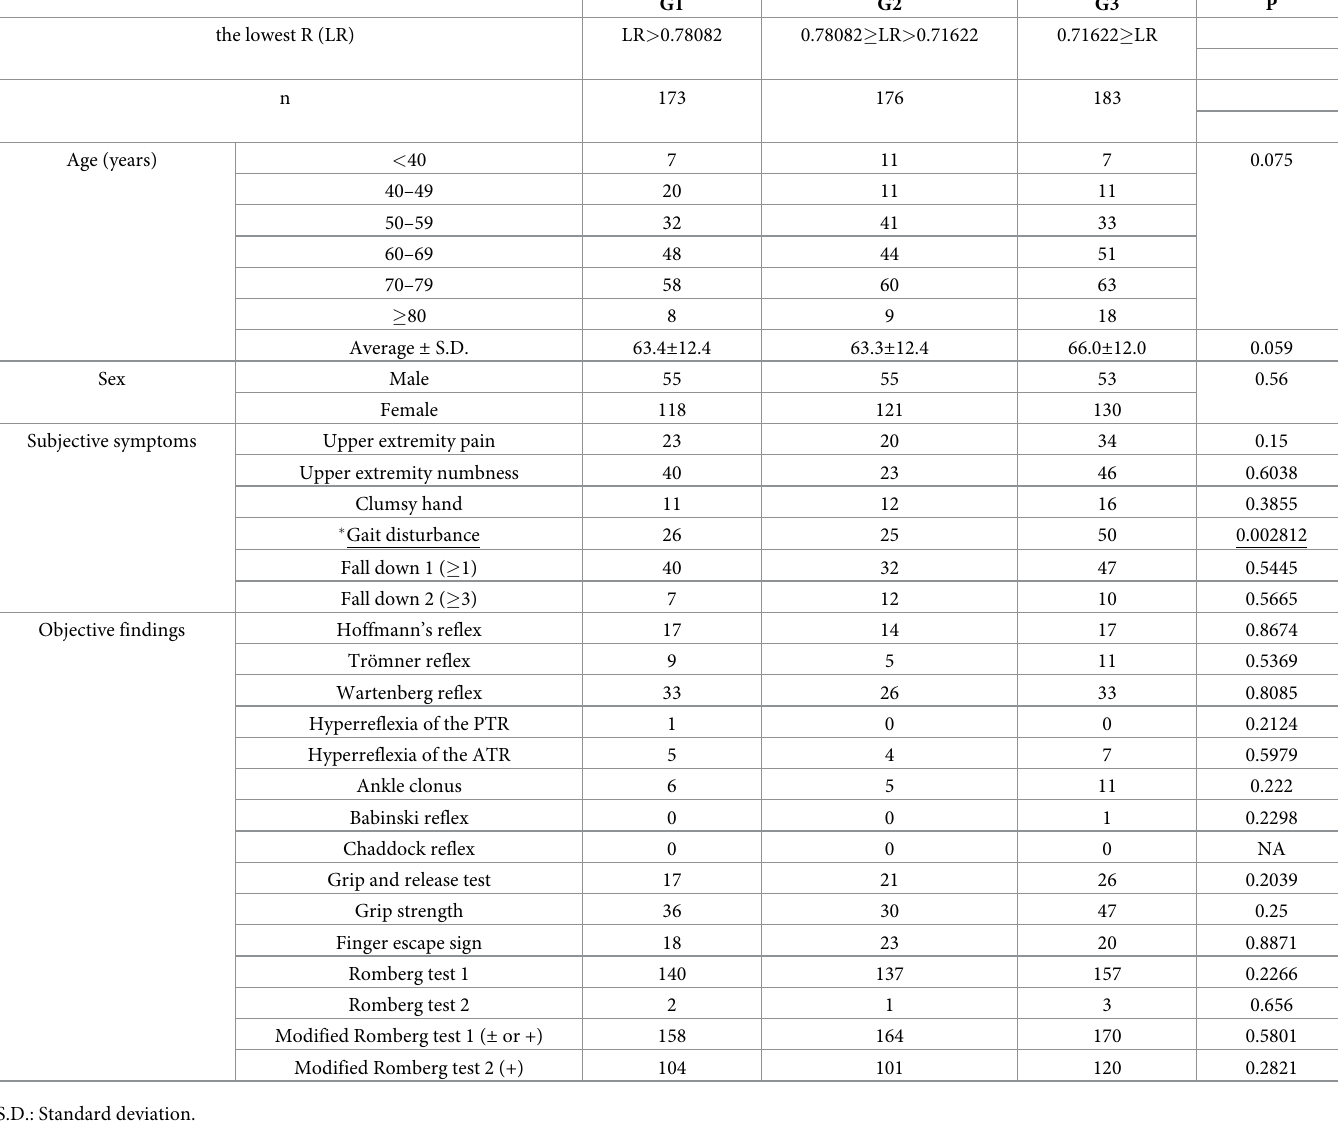
Table 6. Results for age, sex and the prevalence of subjective symptoms and objective findings in each